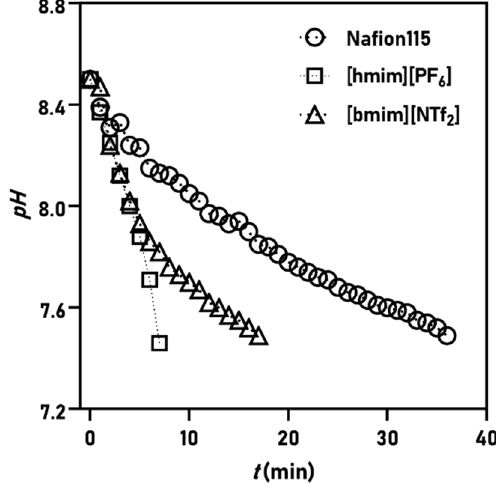
Figure 2. The change in anolyte pH over time using different membranes.